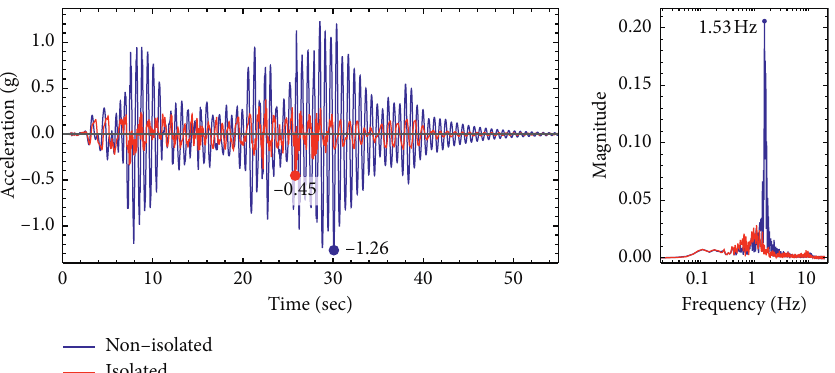
Figure 15: Response histories and corresponding Fourier spectra of the absolute top acceleration of the nonisolated and isolated system with 2% damping at 0.2 (g) seismic qualification level under α � 0.